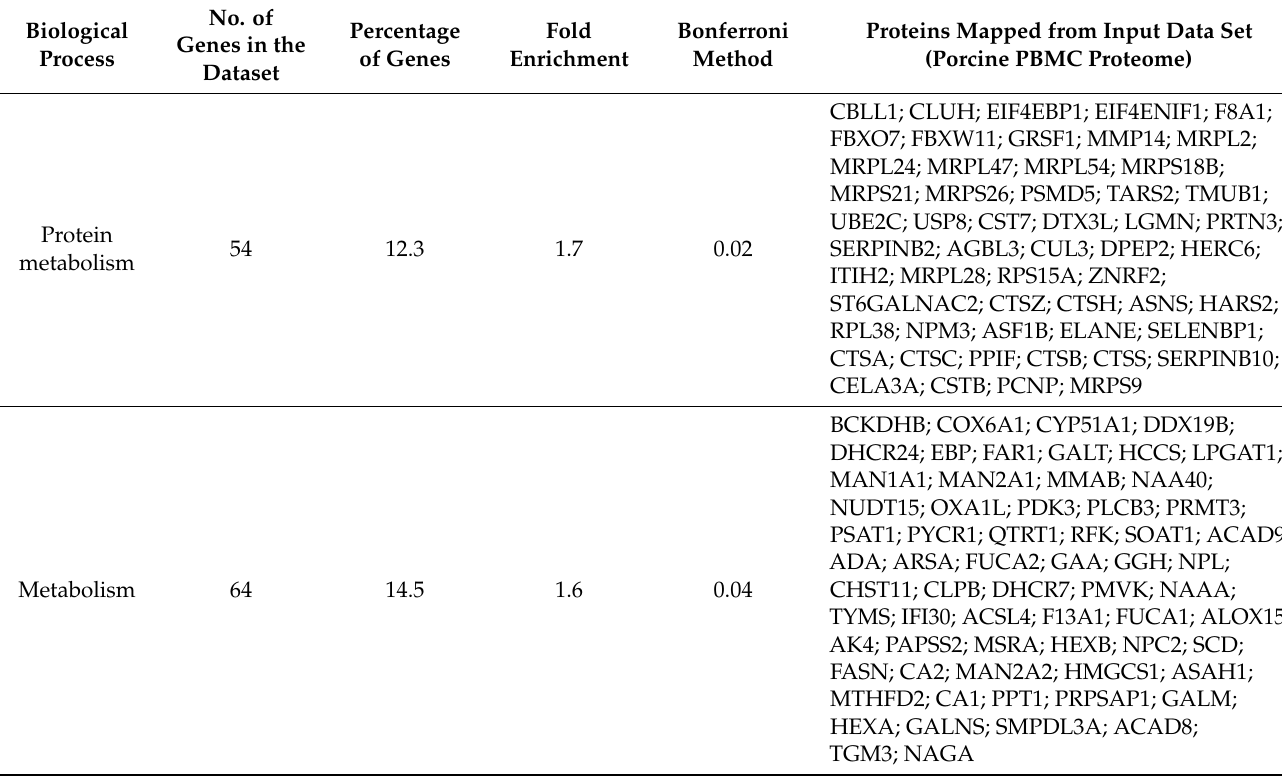
Table 1. Significantly enriched biological processes in BanLec stimulated porcine PBMC.